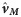
By aggregating related terms, we can create arbitrary constructs representing cultural concepts.In the figure, the vectors representing the terms man and men are added to create a length normalized male construct, v^M. A female construct v^F can be created similarly. Subtracting v^M from v^F results in a vector vG pointing from masculinity towards femininity which when normalized and centered can represent a gender axis v^G. Any term (vpriest) in the model vocabulary can be projected onto this axis, vGpriest=(vpriest∙v^G)v^G, to estimate the degree of association of the term with males or females in the corpus on which the model was trained.